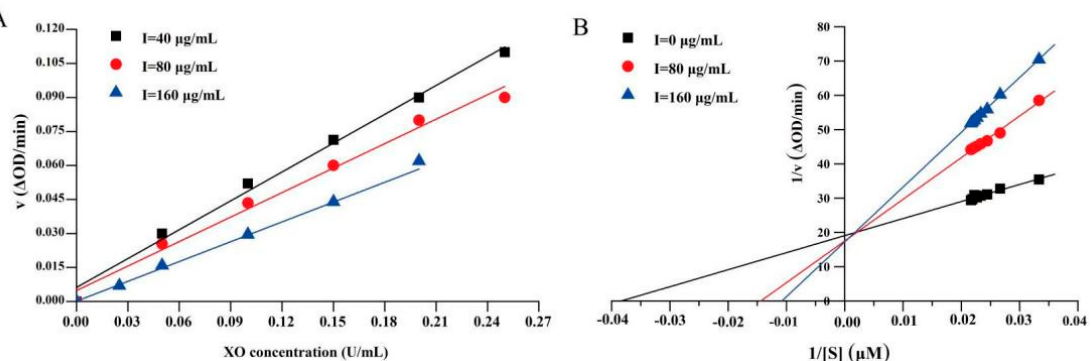
Figure 3. Inhibition kinetics of XO by EtOAc fraction. ( A ) Plots of v vs. [XO]. c (XO) = 150 μ M, c (EtOAc fraction) = 40, 80, and 180 μ g/mL. ( B ) Lineweaver–Burk plots. c (XO) = 0.1 U/mL, c (EtOAc fraction) = 0, 80, and 160 μ g/mL.